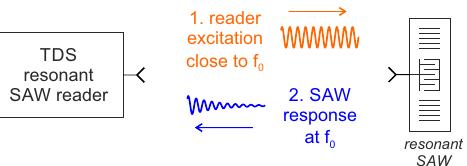
Figure 8. Block diagram of the reader concept for time domain sampling with digital frequency